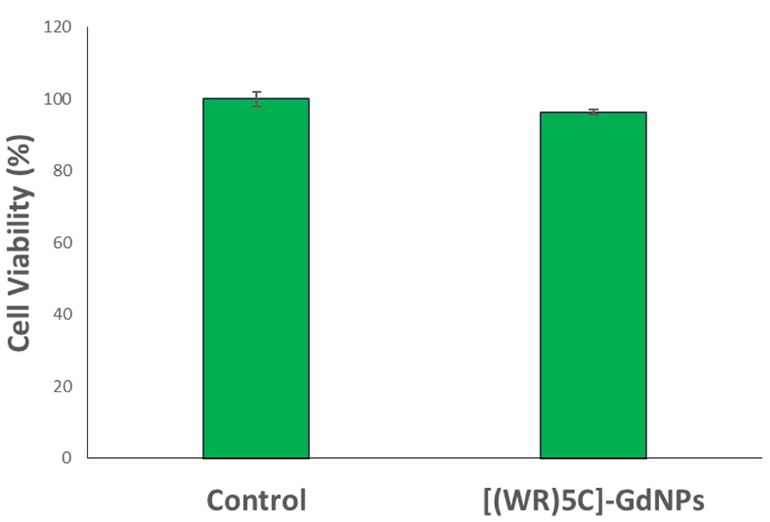
Figure 9. The membrane integrity of [(WR) 5 C]-GdNPs (50 µM) in CCRF-CEM cells after 2 h.